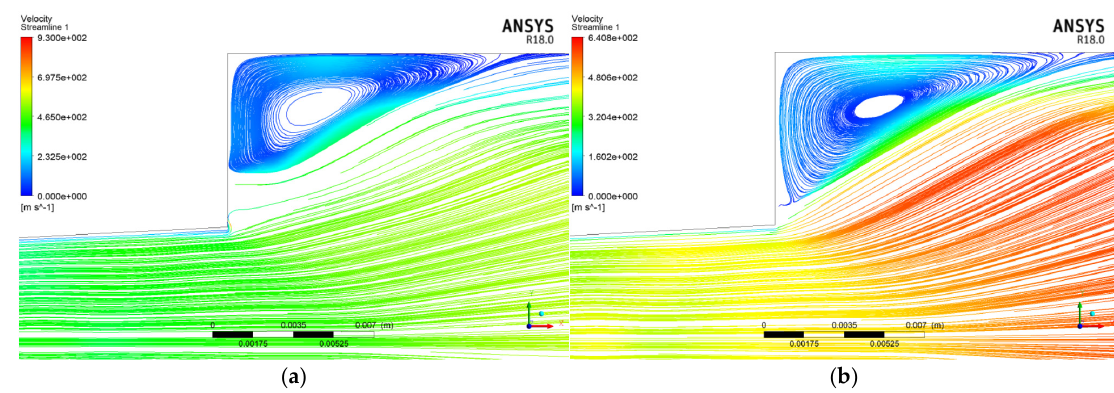
Figure 9. Velocity streamline for area ratio 6.25 ( a ) with control ( b ) without control [132]. Reprinted under the Creative Commons (CC) License (CC BY 4.0).